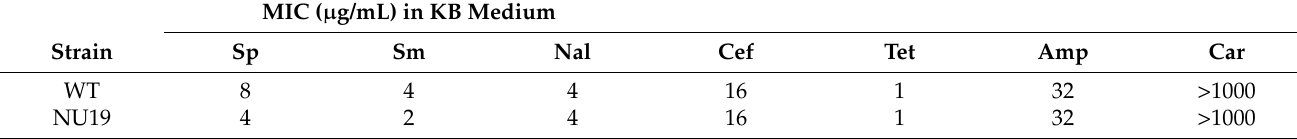
Table 1. Antimicrobial susceptibility of Pcal KB211 WT and NU19. MIC ( µ g/mL) in KB